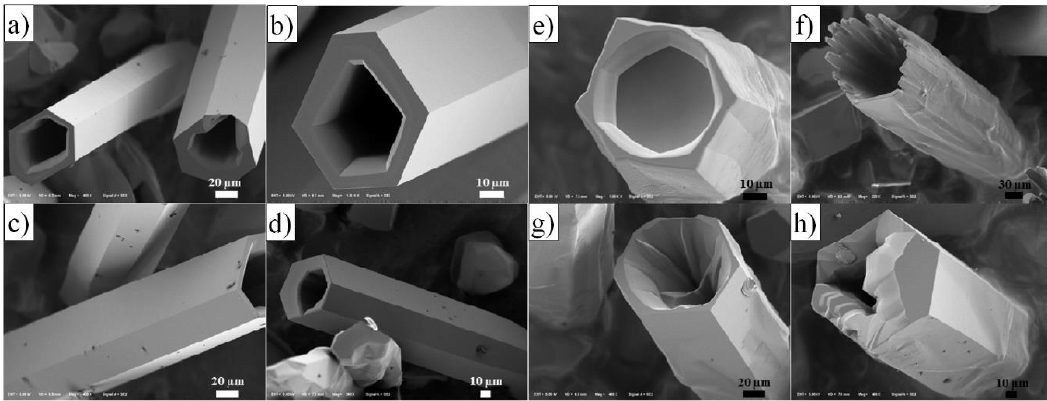
Figure 66. ( a – d ) FESEM images display the shape and morphology of the microwave grown ZnO microtubes. ( a , b ) FESEM images showing the outer hexagonal faceted surfaces and the inner smooth and stepped surface of the ZnO microtubes. ( c , d ) FESEM images showing the side facets and lengths of ZnO microtubes. ( e – h ) FESEM images of ZnO, ( e , f ) semi-microtube at higher temperature and ( g , h ) randomly oriented, tube-like structures of ZnO. Products synthesised by microwave assisted sintering. Reprinted from [869], Copyright (2015), with permission from Elsevier [OR APPLICABLE from the rightsholder.